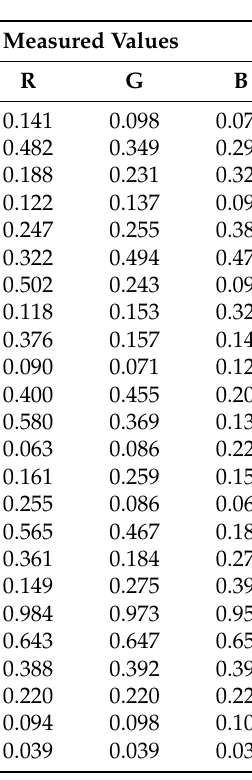
Table 5. Measured and reference sRGB